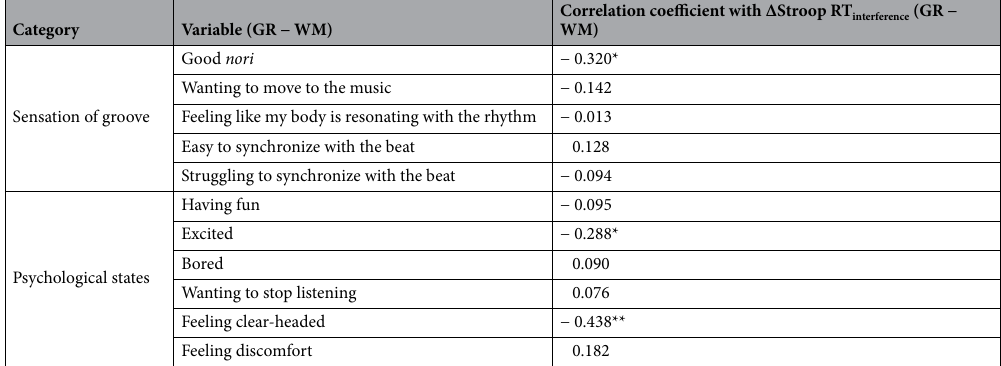
Table 2. Correlation of coefficients between Stroop performance and all psychological variables. There are two categories: “Sensation of groove” and “Psychological state”. * P < 0.05, ** P < 0.01.